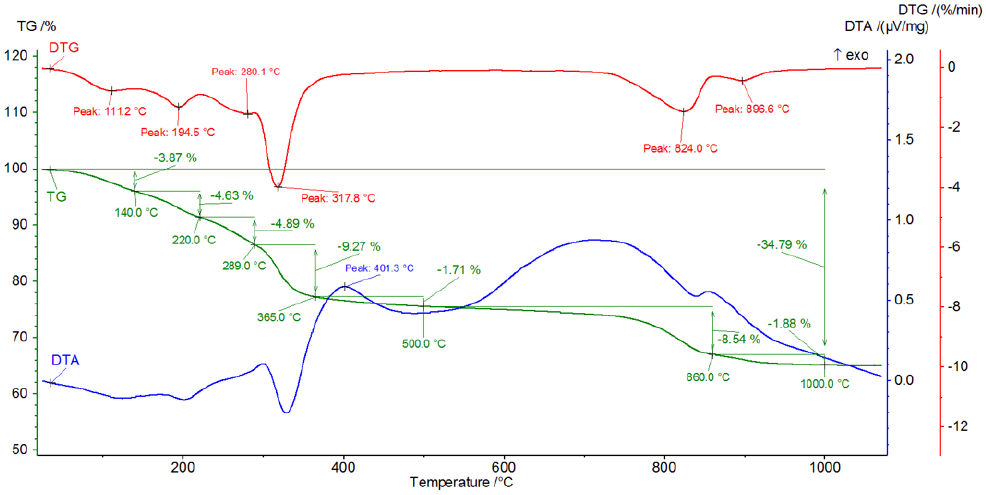
Figure 15. DTA/TG/DTG thermal curves of sample K as a function of temperature in the range 30 – 1000 °C.